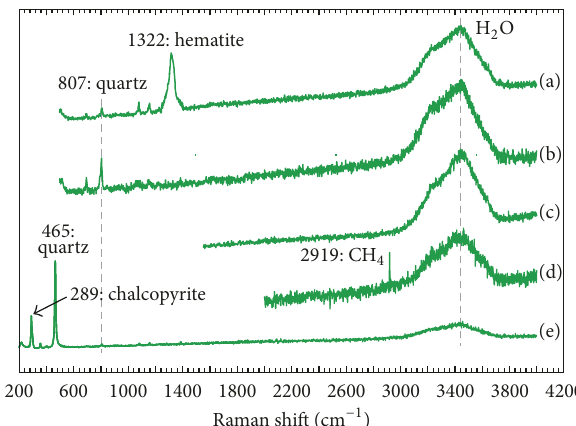
Figure 6: The Laser Raman spectra of fluid inclusions. The analyzed objects are the daughter mineral in a P-stage S-type inclusion (a), the liquid phase in a P-stage V-type inclusion (b), the vapor phase in a B-stage L-type inclusion (c), the liquid phase in a S-stage L-type inclusion (d), and the daughter mineral in a S-stage L-type inclusion (e). The results show that H 2 O is the dominant component of the liquid and vapor phases of all types of fluid inclusions in different stages (a–e), with very small amounts of CH 4 (d). Daughter minerals hematite (a) and chalcopyrite (e) were also identified. P-, S-, and B-stage refer to pre-, syn-, and postmineralization stage,